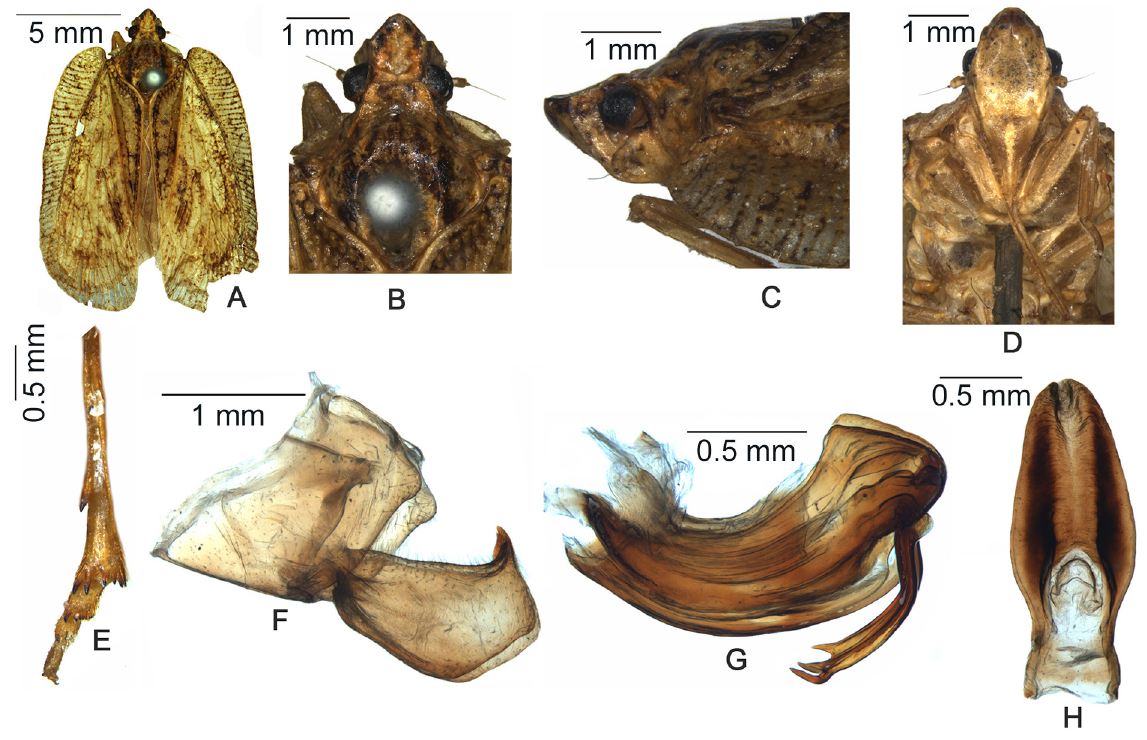
Fig. 11. Atracis ungulata sp. nov. A . Habitus, dorsal view. B . Head and thorax, dorsal view. C . Head and thorax, left lateral view. D . Face. E . Hind leg apex. F . Male genitalia (male anal tube and phallic complex removed), right lateral view. G . Phallic complex, right lateral view. H . Male anal tube, dorsal